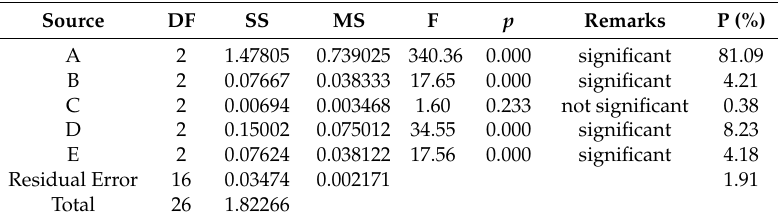
Table 4. ANOVA for S/N ratio (CRA).